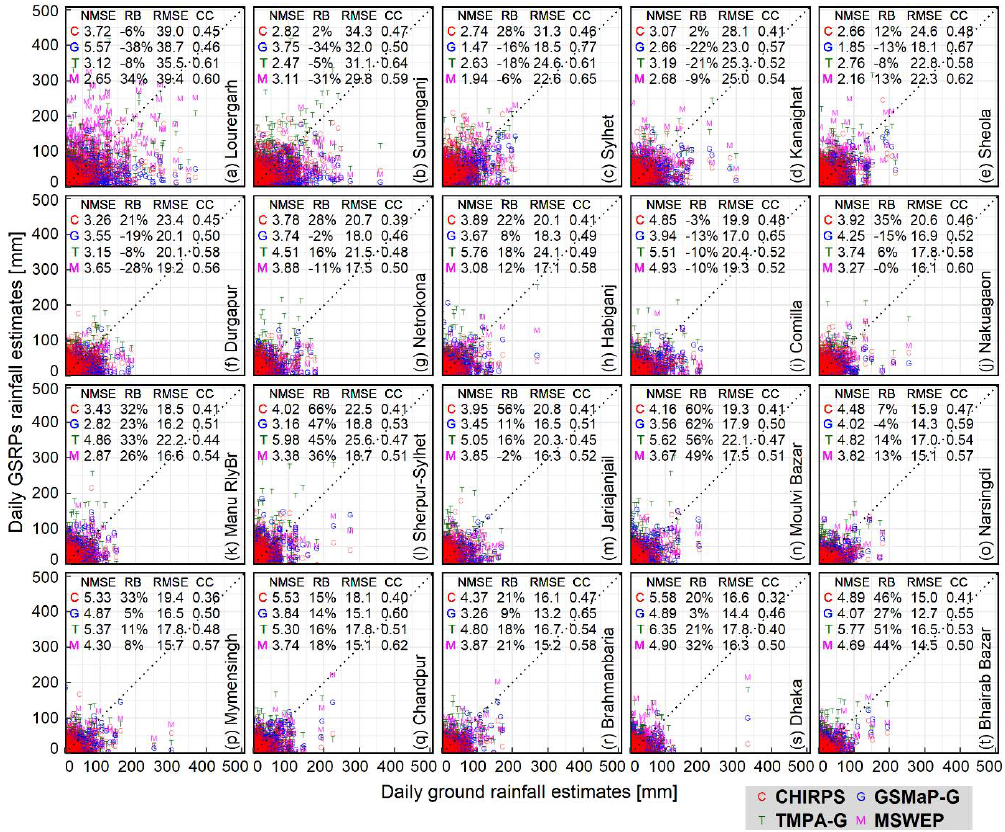
Figure 5. Scatterplots of daily GSRP estimates against daily ground rainfall for the wet seasons